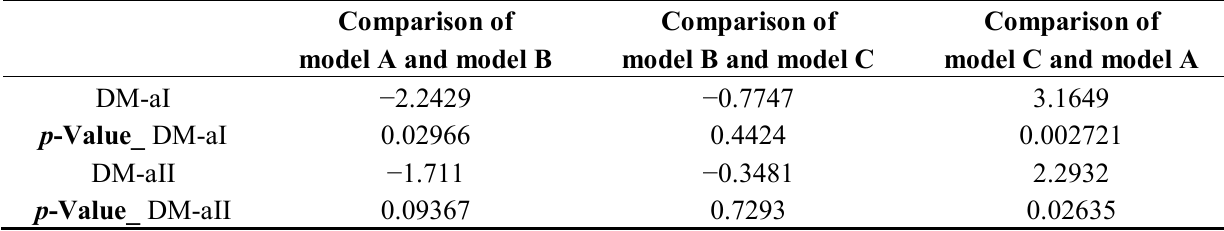
Table 4. Asymmetric DM